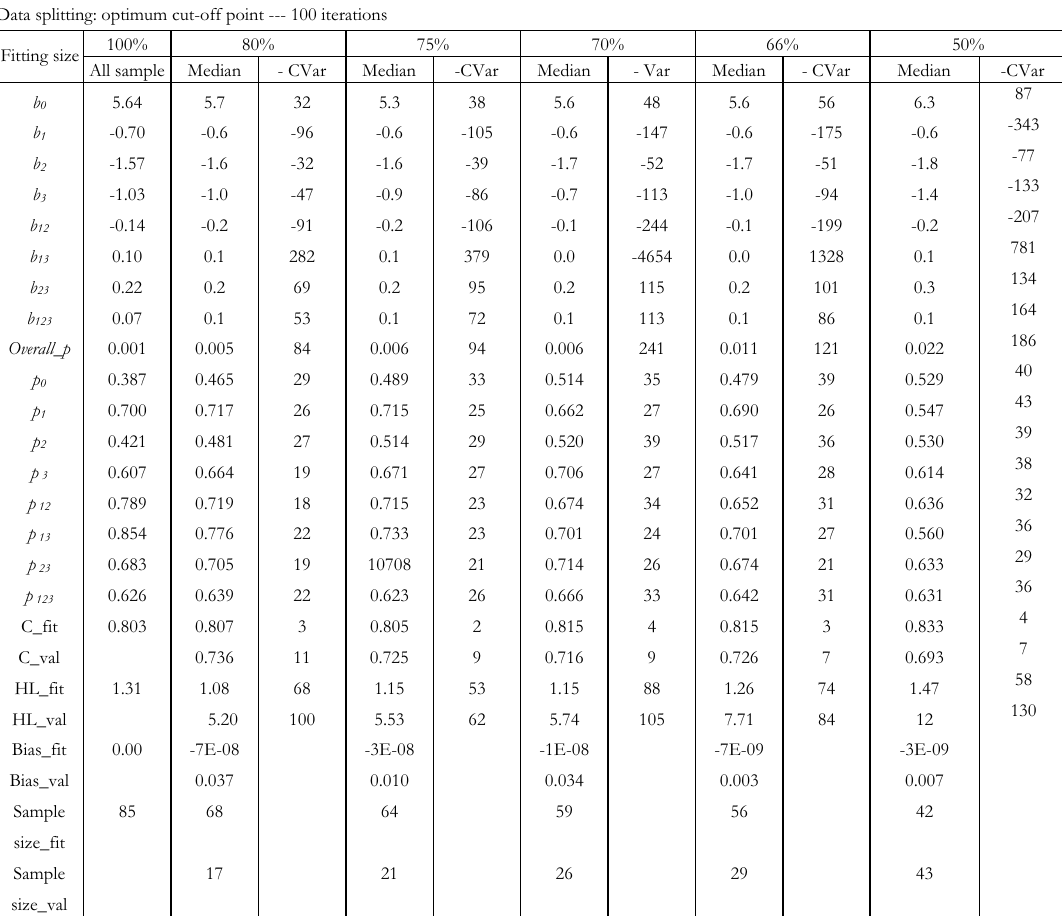
Determination of the optimal size of the fitting and validation